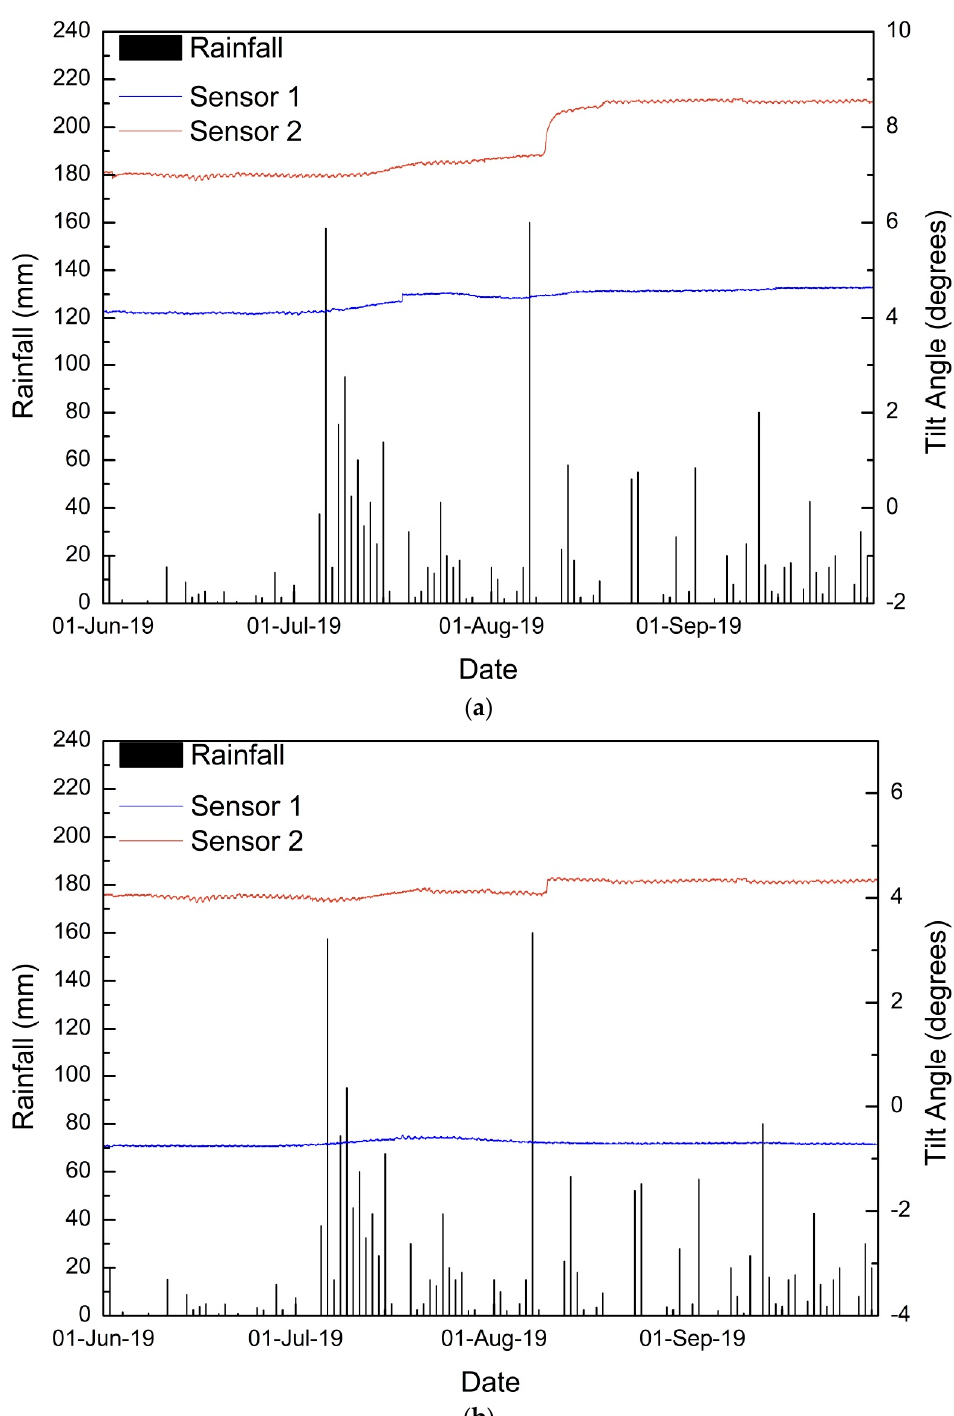
Figure 12. Detailed time history for the monsoon 2019 of sensors 1 and 2: ( a ) tilting angle in the direction parallel to the slope, ( b ) tilting angle in the direction perpendicular to the slope, and ( c ) volumetric moisture